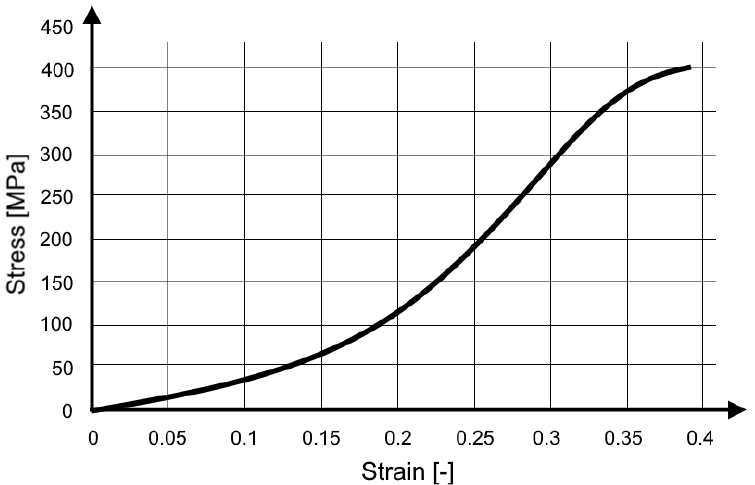
Figure 4. Stress vs. strain curve for the seat belt material [21] (with permission of Editor in Chief of Acta of Bioengineering and Biomechanics).